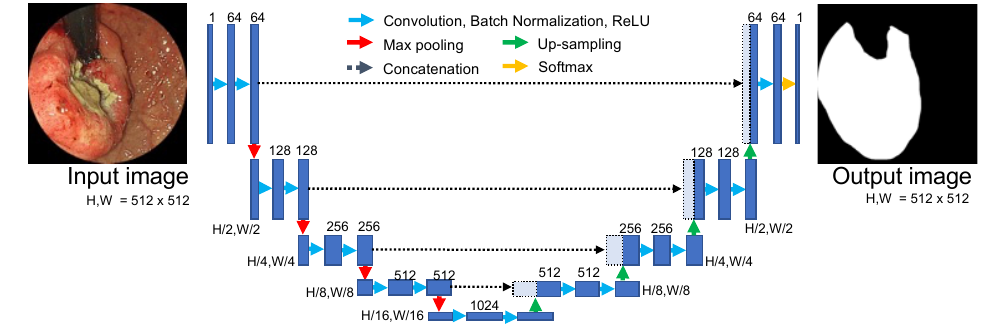
Figure 4. U-Net architecture for gastric cancer segmentation.